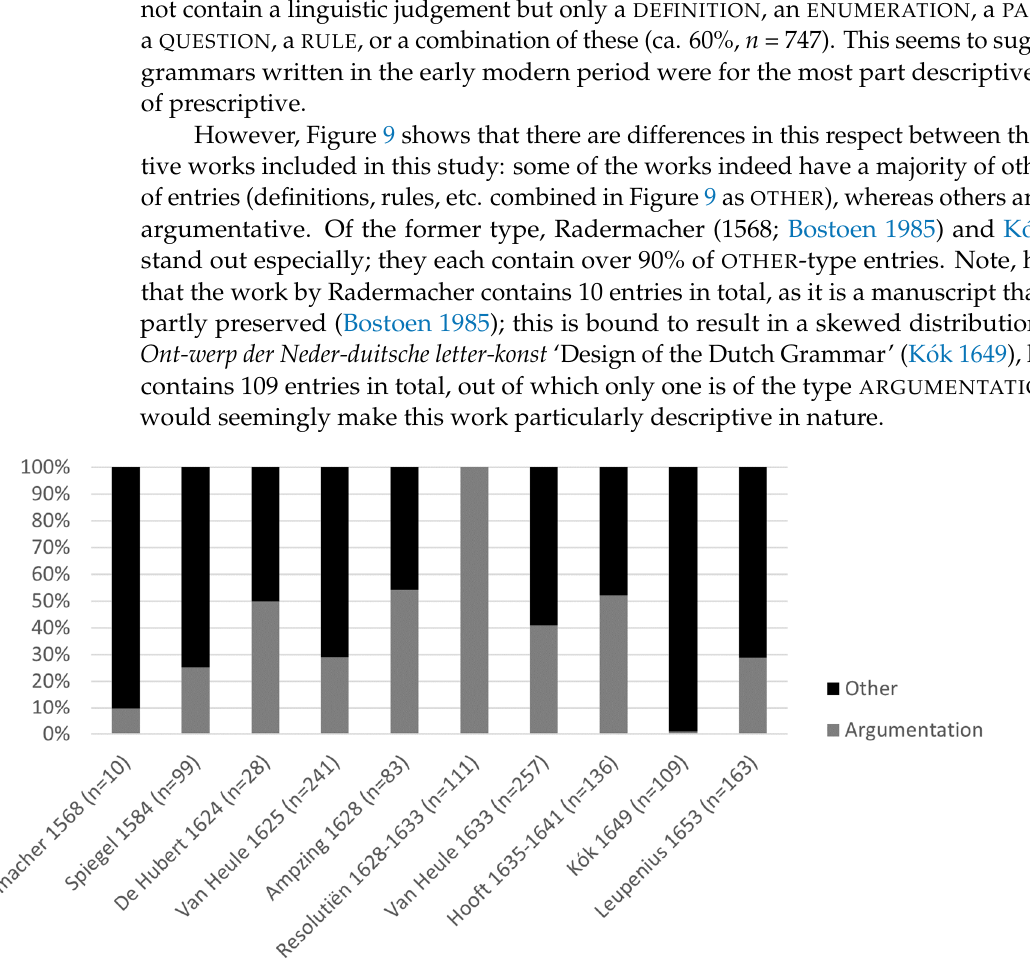
Figure 9. Relative distribution of type of entry per normative work.